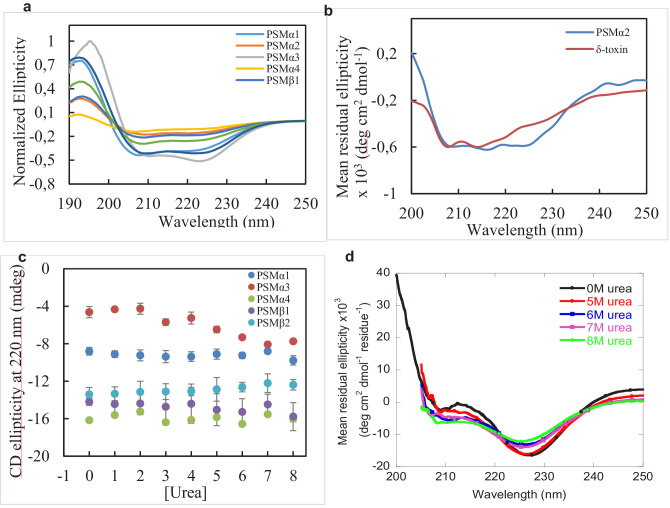
CD spectra of monomeric phenol-soluble modulin (PSM) peptides and urea denaturation of PSM fibrils.CD spectra (Jasco) of monomeric PSM peptides and of PSM peptides that do not aggregate. (a) CD spectra of monomeric PSMs peptides (0.25 mg/mL) measured at 25°C followed by 0 hr of incubation period. (b) Far UV-CD spectra of PSMα2 and δ-toxin after 7 days of incubation at 37°C display α-helical character consistent with the lack of aggregation. (c) Analysis of the dissociation of PSMs fibrils collected from plate reader experiments after incubation in the presence of various concentrations of urea (0–8M). (d) Far UV-CD (Jasco) spectra of PSMα3 fibrils (1 hr) after incubation in the absence and presence of high concentrations of urea (0 and 5–8 M urea).
Figure 2—figure supplement 1—source data 1.Source data for CD spectra of monomeric phenol-soluble modulin (PSM) peptides and urea denaturation of PSM fibrils.